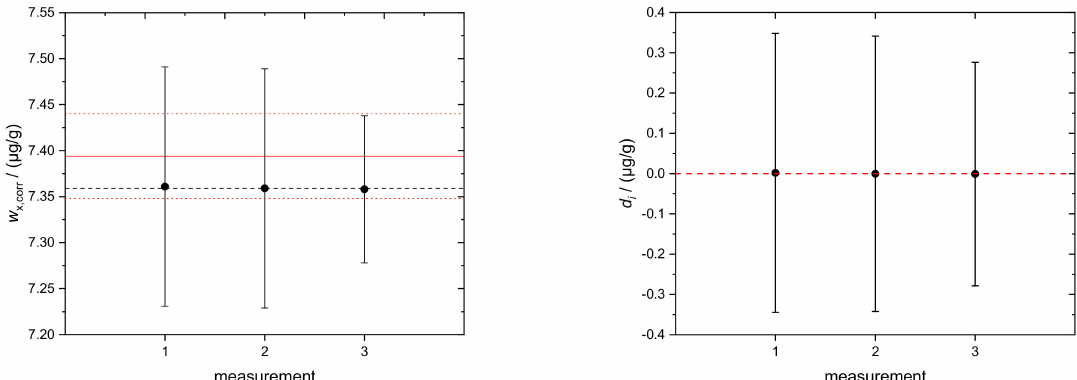
Figure 6. ( Left ) Black circles: corrected mass fractions w x,corr (S) of sulfur in BDF and the associated uncertainties ( k = 1); black dashed line: average of three single runs. Data from the new combined IDMS/standard addition approach (this work). Red solid line: average value of w (S) from BAM, applying IDMS and using the same solution [23]. Upper and lower associated uncertainties: red dotted lines. ( Right ) Degrees of equivalence ( d i ) of the respective measurement results. Error bars indicate expanded uncertainties ( k = 2) associated with d i . All single results are consistent with the average value since the respective uncertainties encompass the red dashed zero